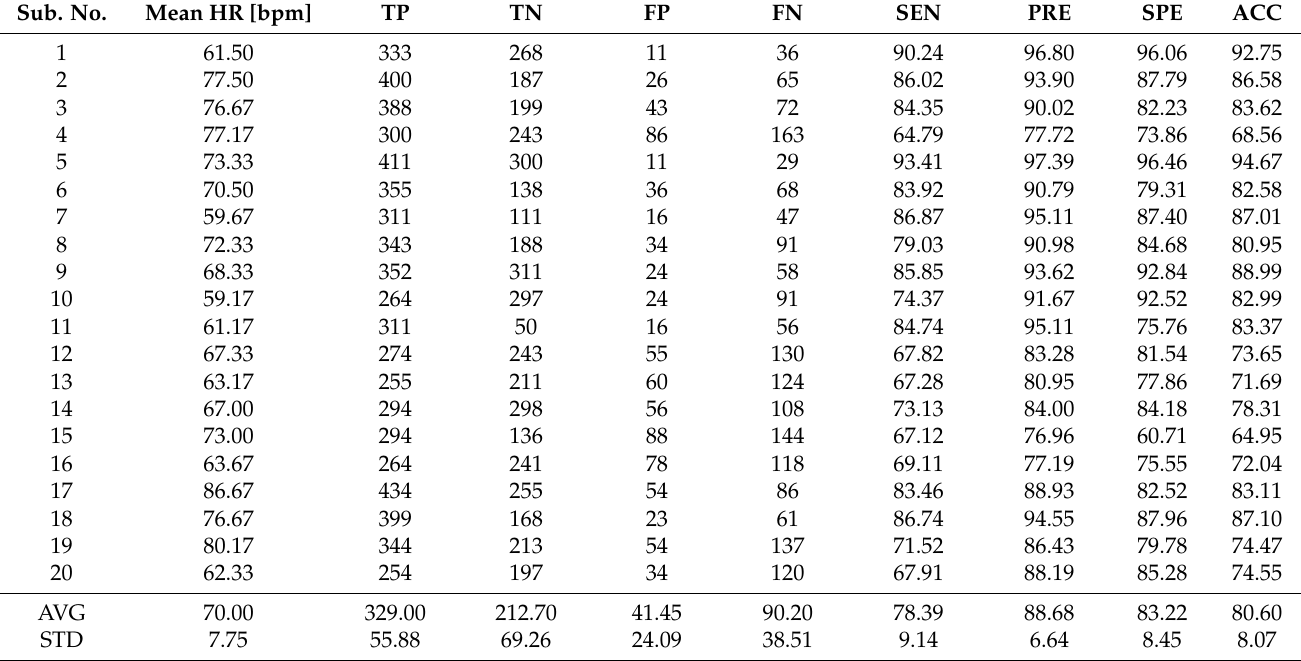
Table 6. Performance of the S2 peak detection in Model